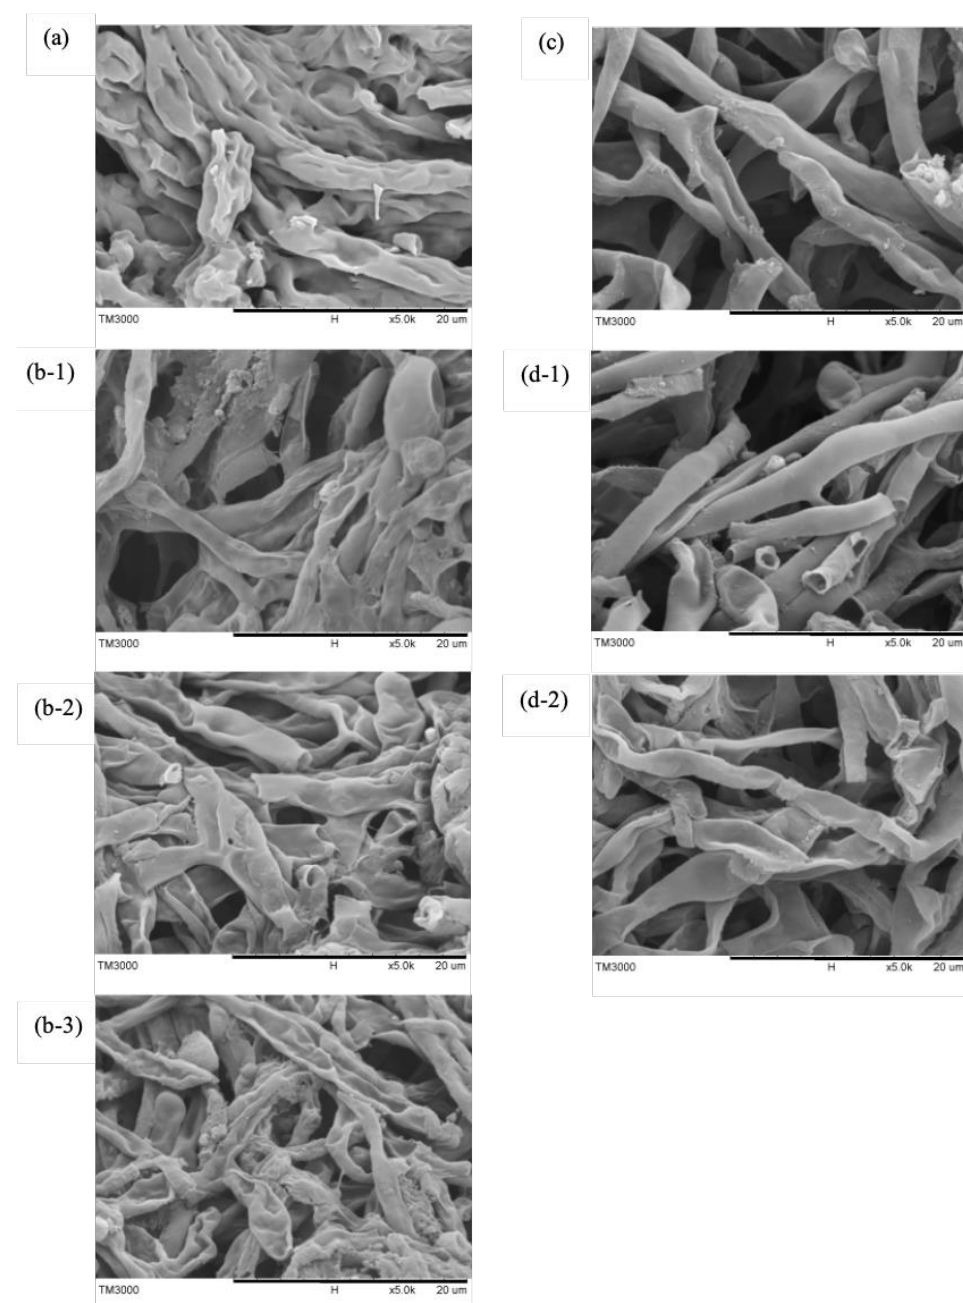
Figure 2. SEM images of M. alpina FU30797 in 5k magnitudes, where: ( a ) untreated biomass, ( b ) HCl treatment: 1 M ( b-1 ), 2 M ( b-2 ), 3 M( b-3 ), ( c ) ultrasonication 20 W and ( d ) HPP (600 MPa, 1 time) by water medium( d-1 ) and ethanol medium( d-2 ).